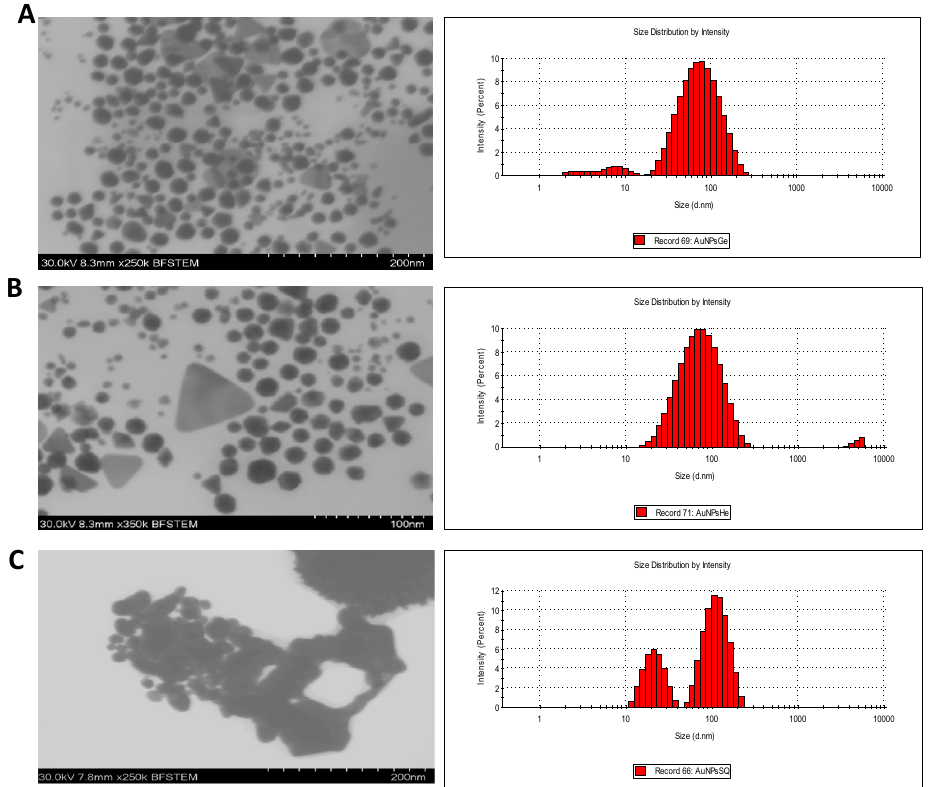
Figure 3. Scanning transmission electron microscope (STEM) and dynamic light scattering (DLS) analyses from ( A ) AuNPsME; ( B ) AuNPsCE; and ( C ) AuNPsCS. AuNPsCE: Gold nanoparticles synthesized with a castor ( R. communis ) leaves extract; AuNPsCS: Gold nanoparticles produced by chemical synthesis; AuNPsME: Gold nanoparticles synthesized with common mullein ( V. thapsus ) flowers ethanolic extract.